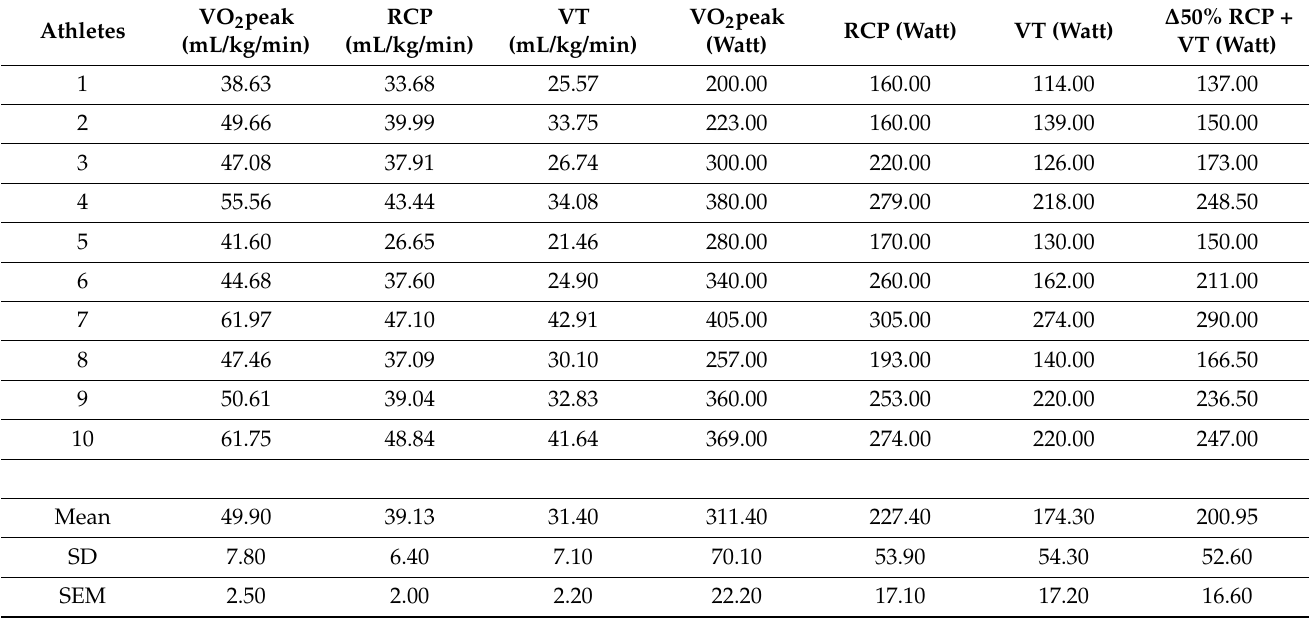
Table 1. Oxygen uptake and workload